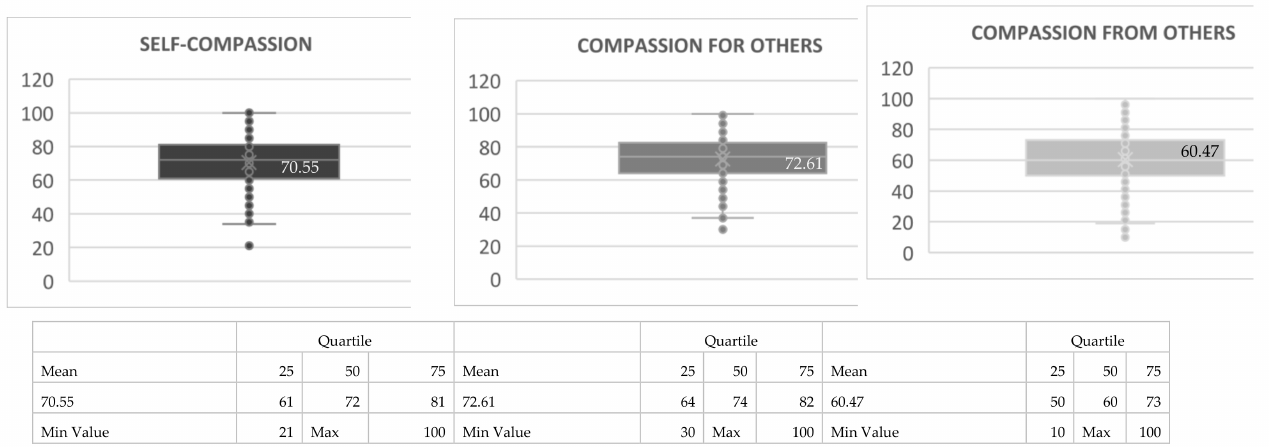
Figure 2. Gilbert ´ s compassion scale.